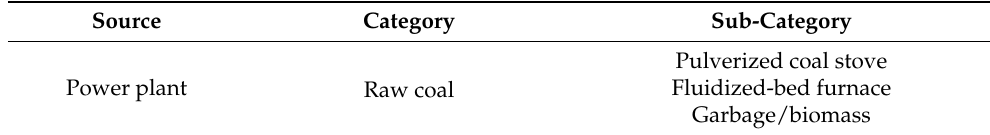
Table 1. Classification of emission